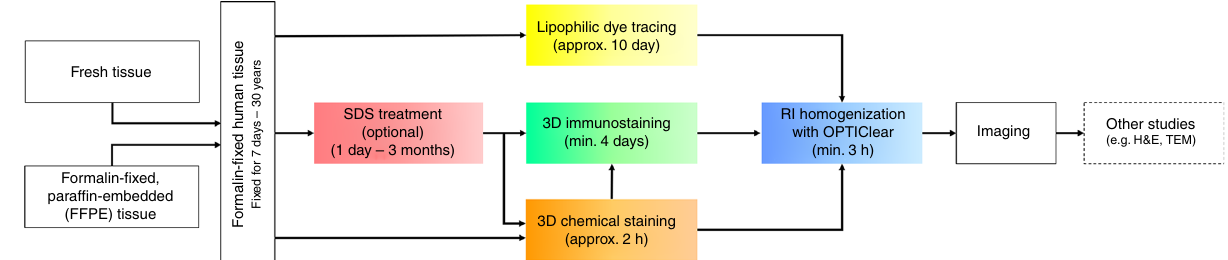
Fig. 6 Flowchart summarising the next-generation histology protocol developed in this paper. The protocol outlined here enables both fresh and archival formalin- fi xed paraf fi n-embedded (FFPE) post-mortem tissues to be processed for tissue clearing. Formalin- fi xed tissues can then be stained using immunohistochemical or non-immunohistochemical techniques such as lipophilic dye tracing with DiI or 3D chemical staining with cresyl violet. An optional SDS delipidation step is recommended before 3D immunostaining or chemical staining. Subsequently, tissues are rendered optically transparent with refractive index homogenization using OPTIClear before imaging or proceeding to other studies such as electron microscopy. H&E, haematoxylin & eosin; RI, refractive index; SDS, sodium dodecyl sulphate; TEM, transmission electron